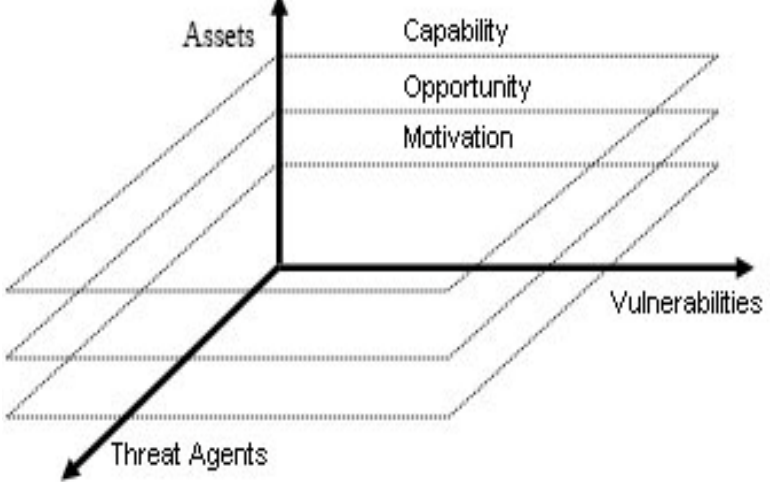
Figure 3. Three-Dimensional Matrix and 3D Representation of Threat Assessment.